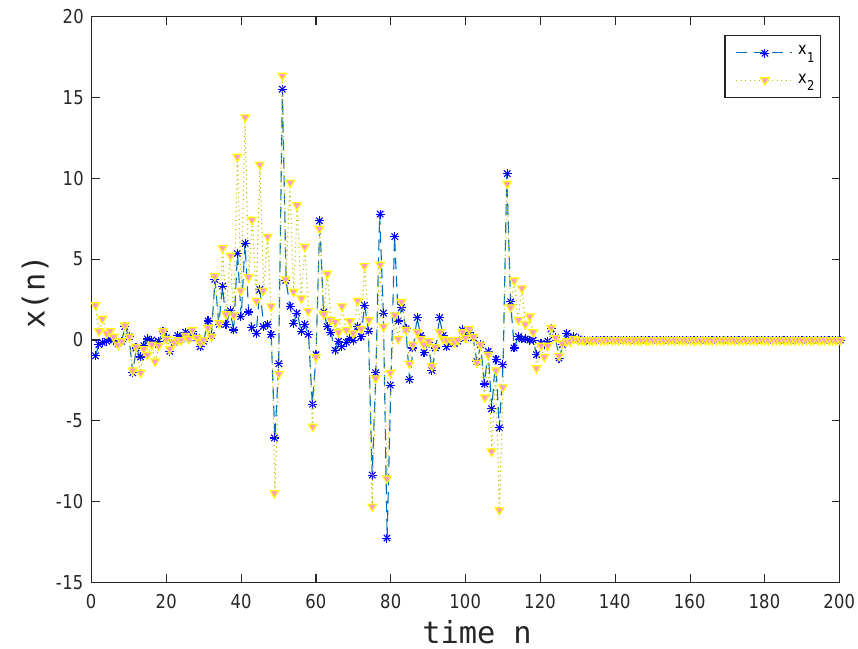
Figure 3. State trajectories of system (40) with